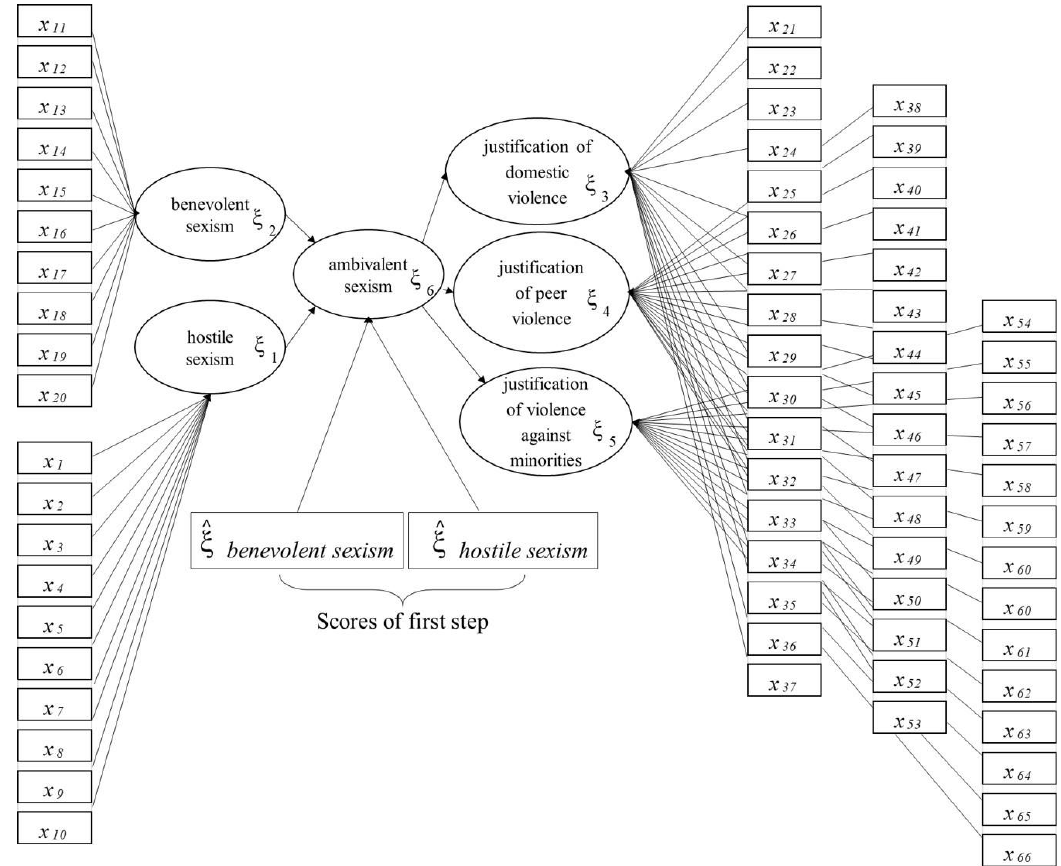
Figure 3. Structural and measurement model: the second step of the mixed two-step approach with the scores of first step as the MVs for the ambivalent sexism LVs.